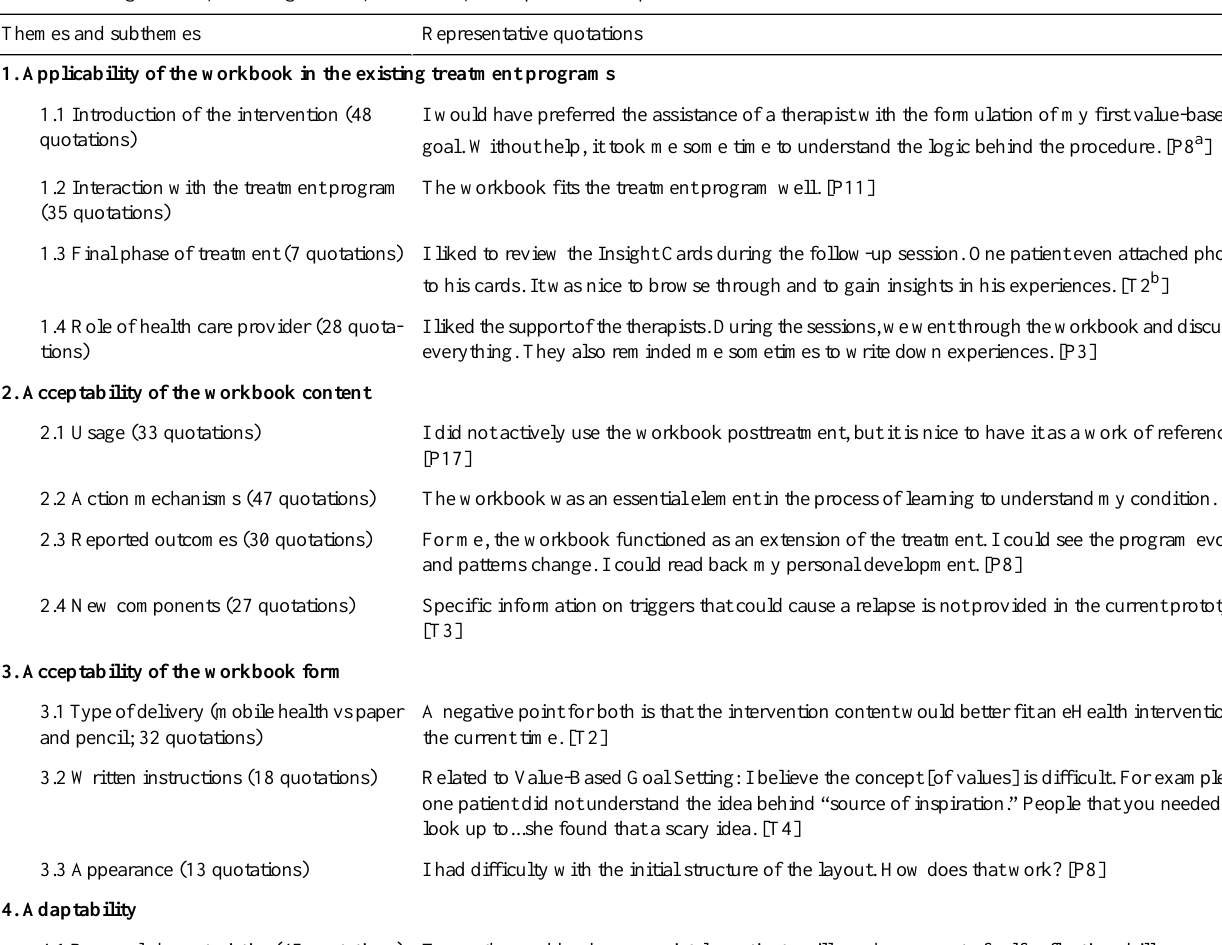
Table 2. Coding scheme, including themes, subthemes, and representative